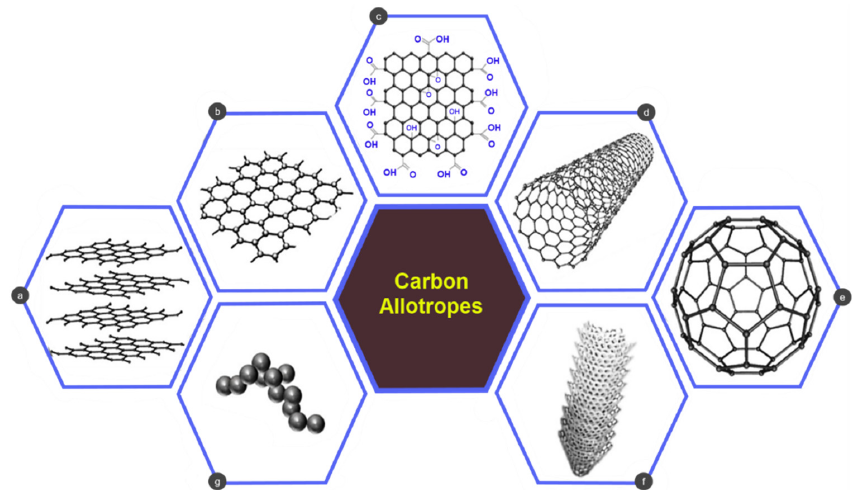
Figure 1. Carbon allotropic forms: ( a ) graphite, ( b ) graphene, ( c ) graphene oxide, ( d ) carbon nano- tubes, ( e ) fullerene, ( f ) carbon nanofibers, ( g ) carbon dot; Reprinted with permission [28].